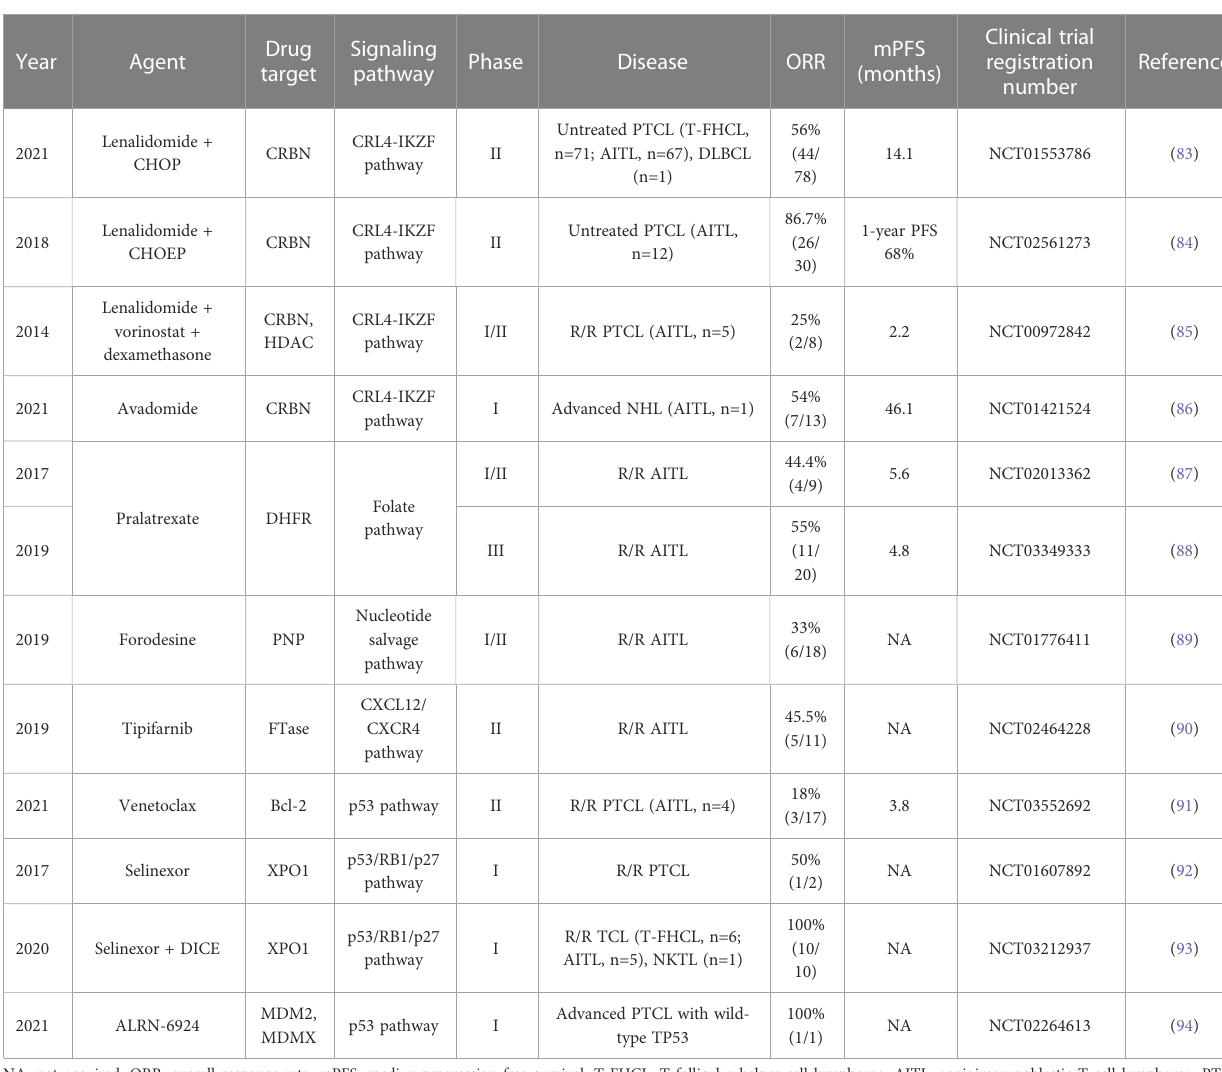
TABLE 6 Other novel targeted agents in